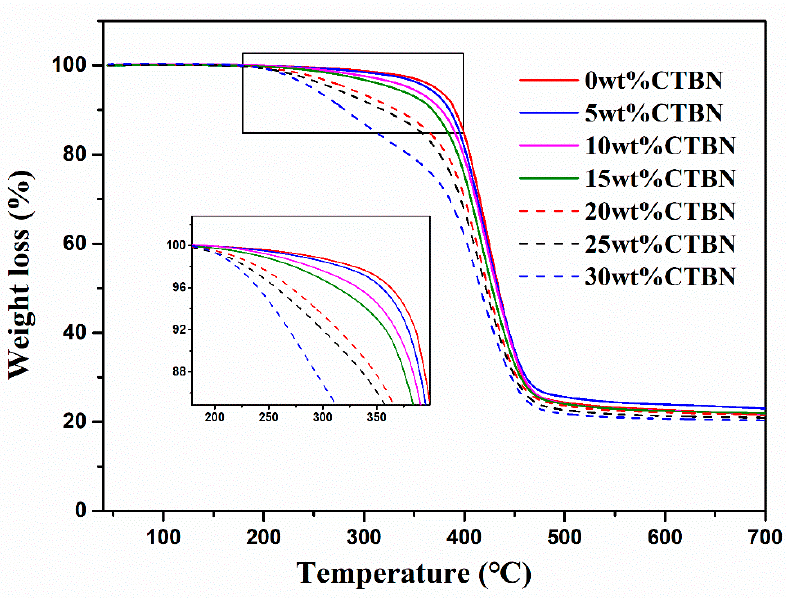
Figure 4. TGA curves of composites with different CTBN contents. Table 1. Thermal stability of CTBN epoxy resin composites.